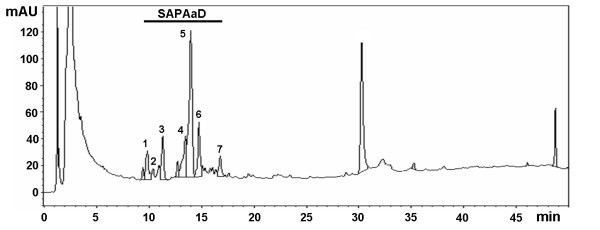
HPLC fingerprinting of SAPAaD. The retention times of saponins are (in min): 1–9.42, 2–9.85, 3–11.32, 4–13.46, 5–13.79, 6–14.75 and 7–16.78. Detection, 205 nm; mAU, milli absorbance unit.